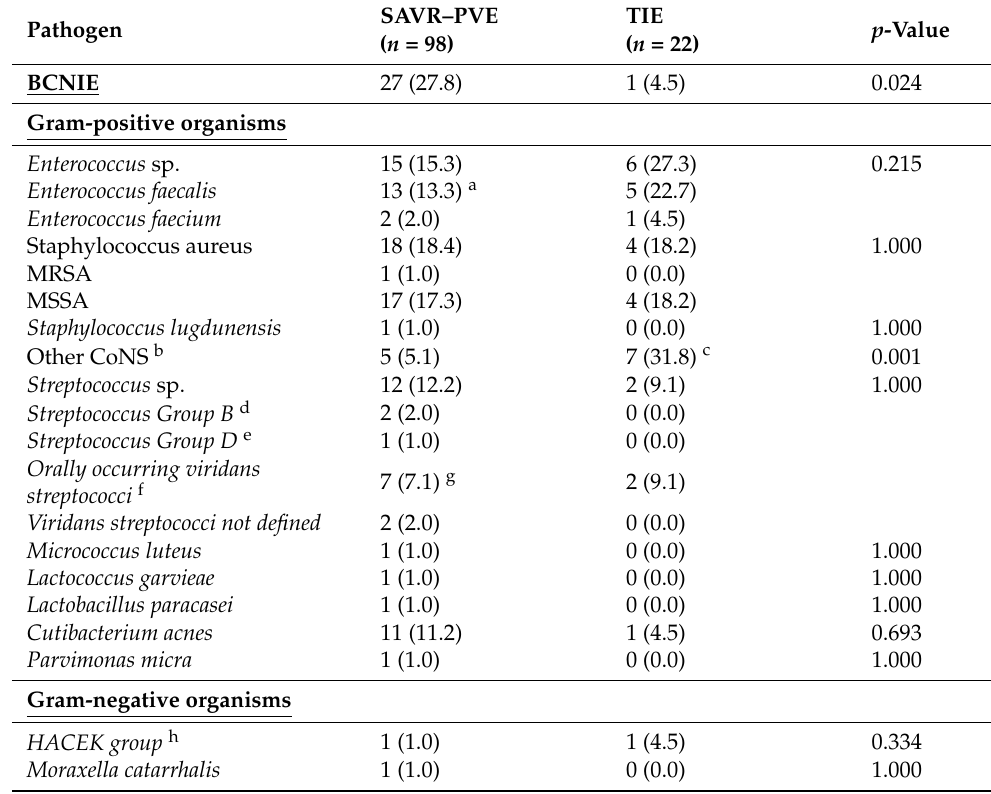
Table 4. Spectrum of pathogens. BCNIE, blood-culture-negative infective endocarditis; CoNS, coagulase-negative staphylococci; MSSA, methicillin-susceptible Staphylococcus aureus ; MRSA, methicillin-resistant Staphylococcus aureus . a Includes one polymicrobial infection: Enterococcus